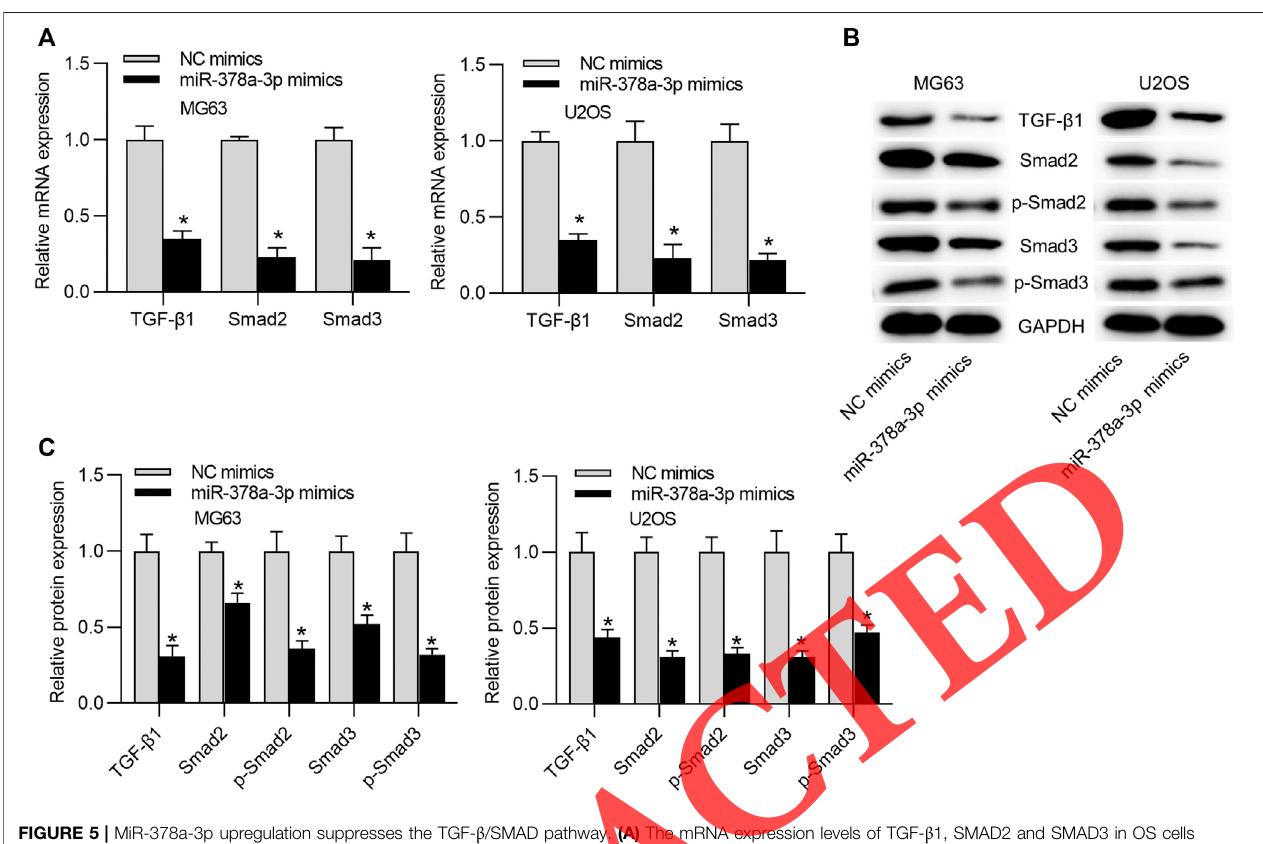
FIGURE 5 | MiR-378a-3p upregulation suppresses the TGF- β /SMAD pathway. (A) The mRNA expression levels of TGF- β 1, SMAD2 and SMAD3 in OS cells transfected with NC mimics or miR-378a-3p mimics were determined by RT-qPCR analysis. Signi fi cance was analyzed by Student ’ s t-test. (B,C) Western blot measured the protein levels of TGF- β 1, SMAD2, SMAD2 (phospho S255), SMAD3, and SMAD3 (phospho T179) in OS cells transfected with sh-LINC00174 or sh-NC group. Signi fi cance was analyzed by Student ’ s t-test. * p <